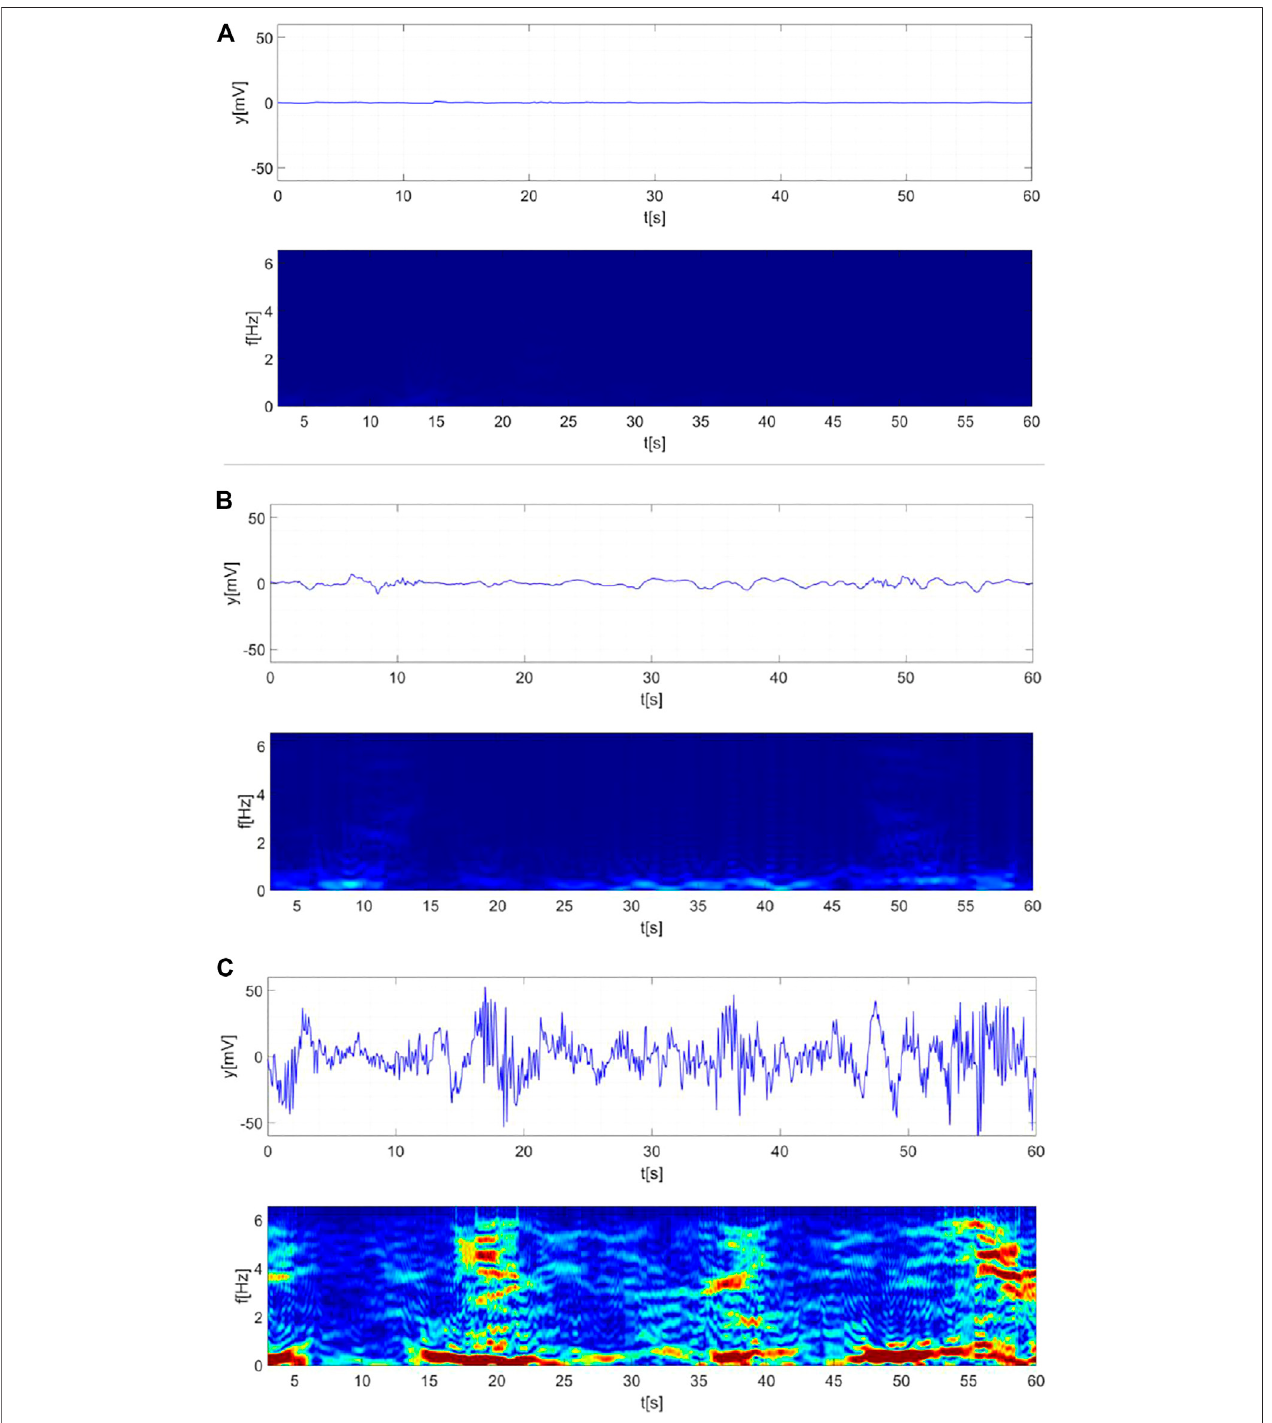
FIGURE 8 | Radar signals (top panels) and normalized Doppler spectra (bottom panels). Empty scene (A) . Static subject 3 m far away from the radar (B) . Moving subject (C) . Color scale [0, 0.4].